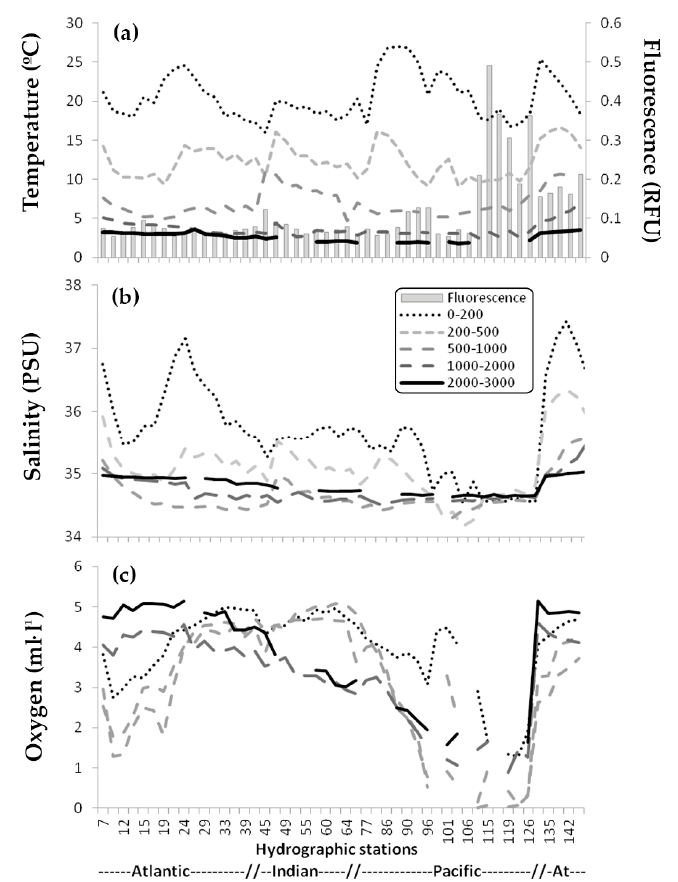
Figure 2. ( a ) Temperature (°C) and in situ fluorescence (RFU: Relative Fluorescence Units), ( b ) salinity (PSU: Practical Salinity Units), ( c ) dissolved oxygen concentration (mL·L − 1 ) determined at each hydrographic station and depth strata (data averaged within depth layers).